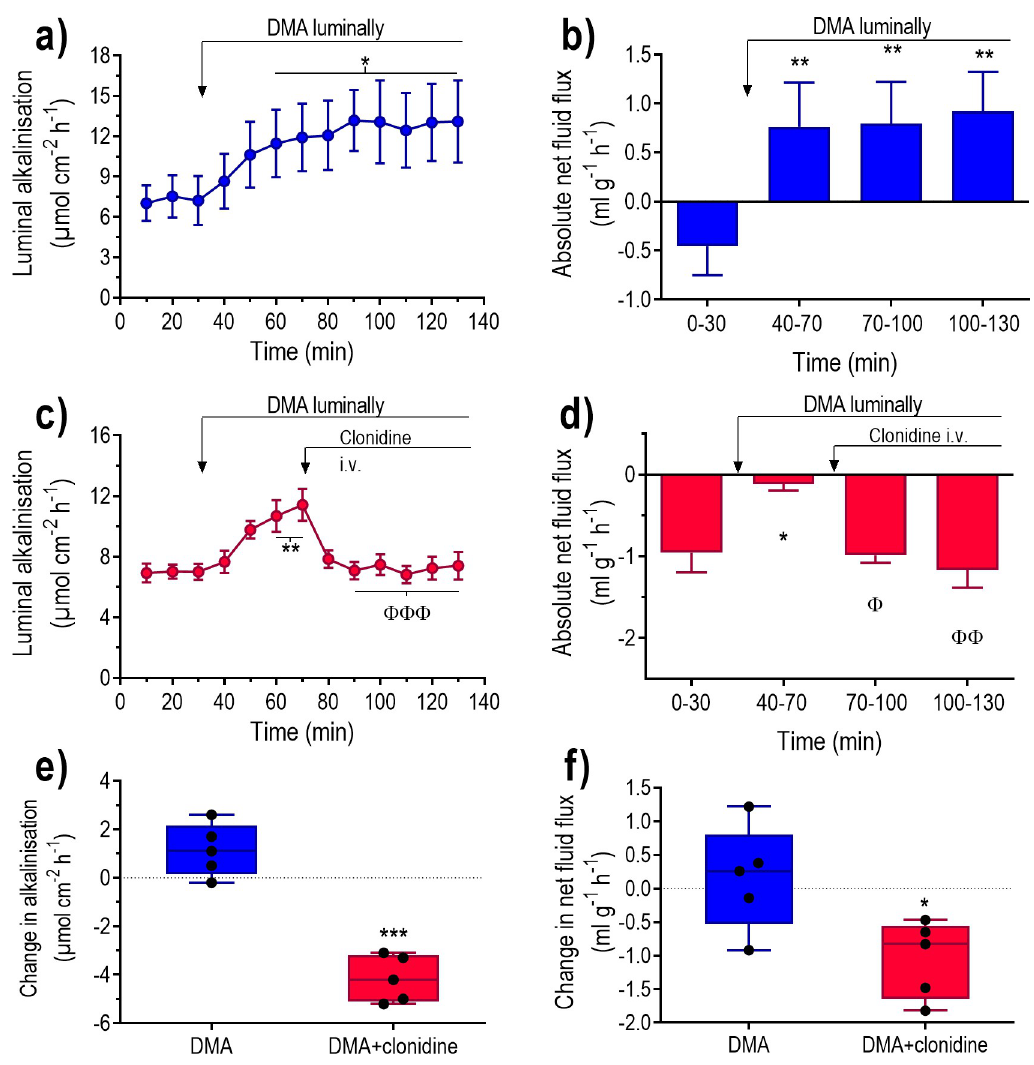
Fig 6. The effects of clonidine on fluid flux and luminal alkalinisation in the rat duodenum perfused with DMA. Duodenum was perfused with isotonic saline for 30 min and subsequently with isotonic dimethylamiloride (DMA) solution (10 − 3 M) for 100 min (Fig 1). Effects on luminal alkalinisation (a and c) and transepithelial net fluid flux (b and d) in the absence and presence of i.v. infusion of clonidine at a dose of 10 μ g kg -1 h -1 . Net changes in (e) luminal alkalinisation and (f) transepithelial net fluid flux between 110–130 min and 50–70 min (DMA plus clonidine vs DMA alone). Values are means ± SEM or box plots with all individual points. � P < 0.05 and �� P < 0.01 compared with basal values. F P < 0.05, FF P < 0.01 and FFF P < 0.001 compared with values at 50–70 min. Fig (e) and (f); � P < 0.05 and ��� P < 0.001 compared with values in animals treated with DMA